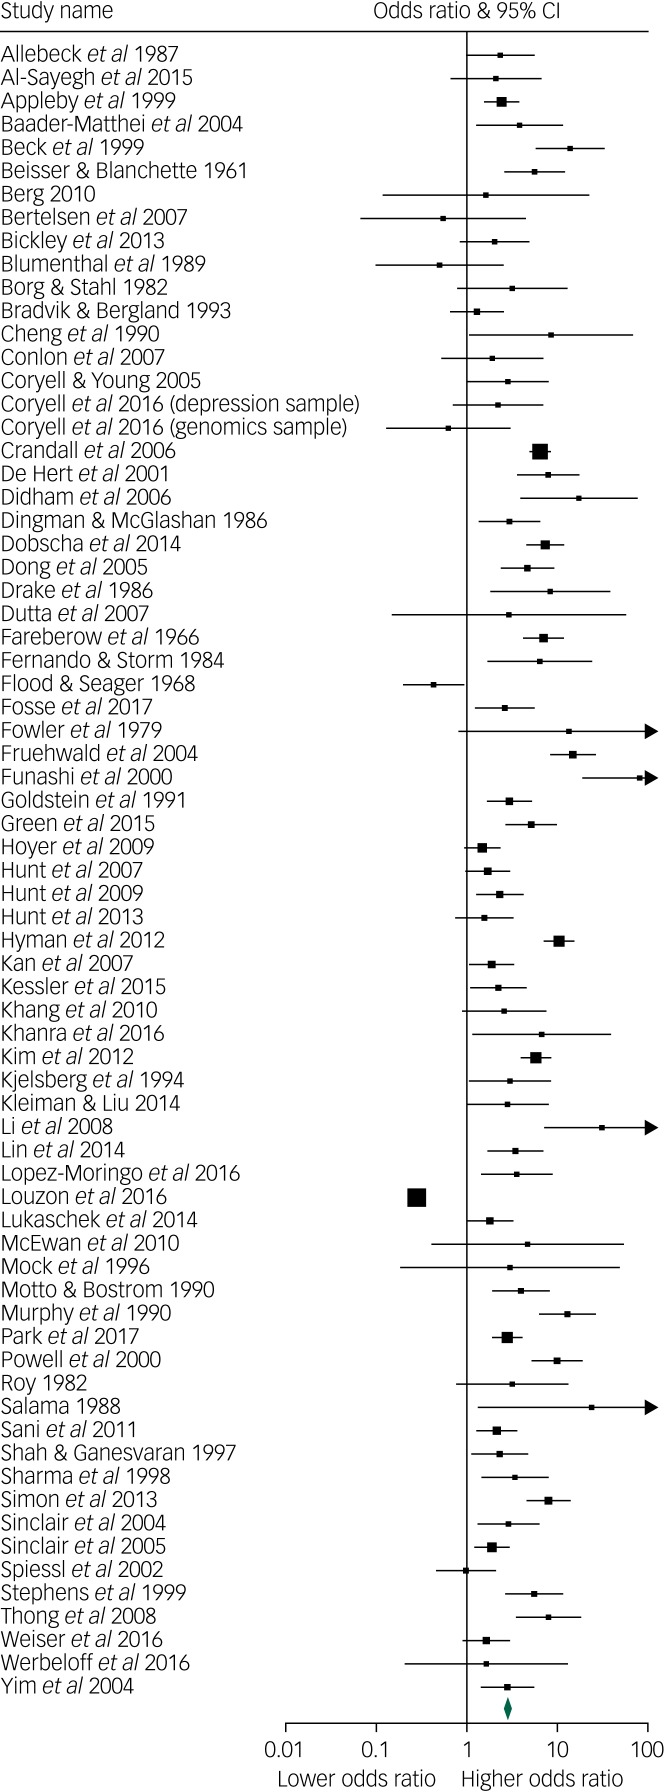
Forest plot of the odds of the association between suicidal ideation and suicide.